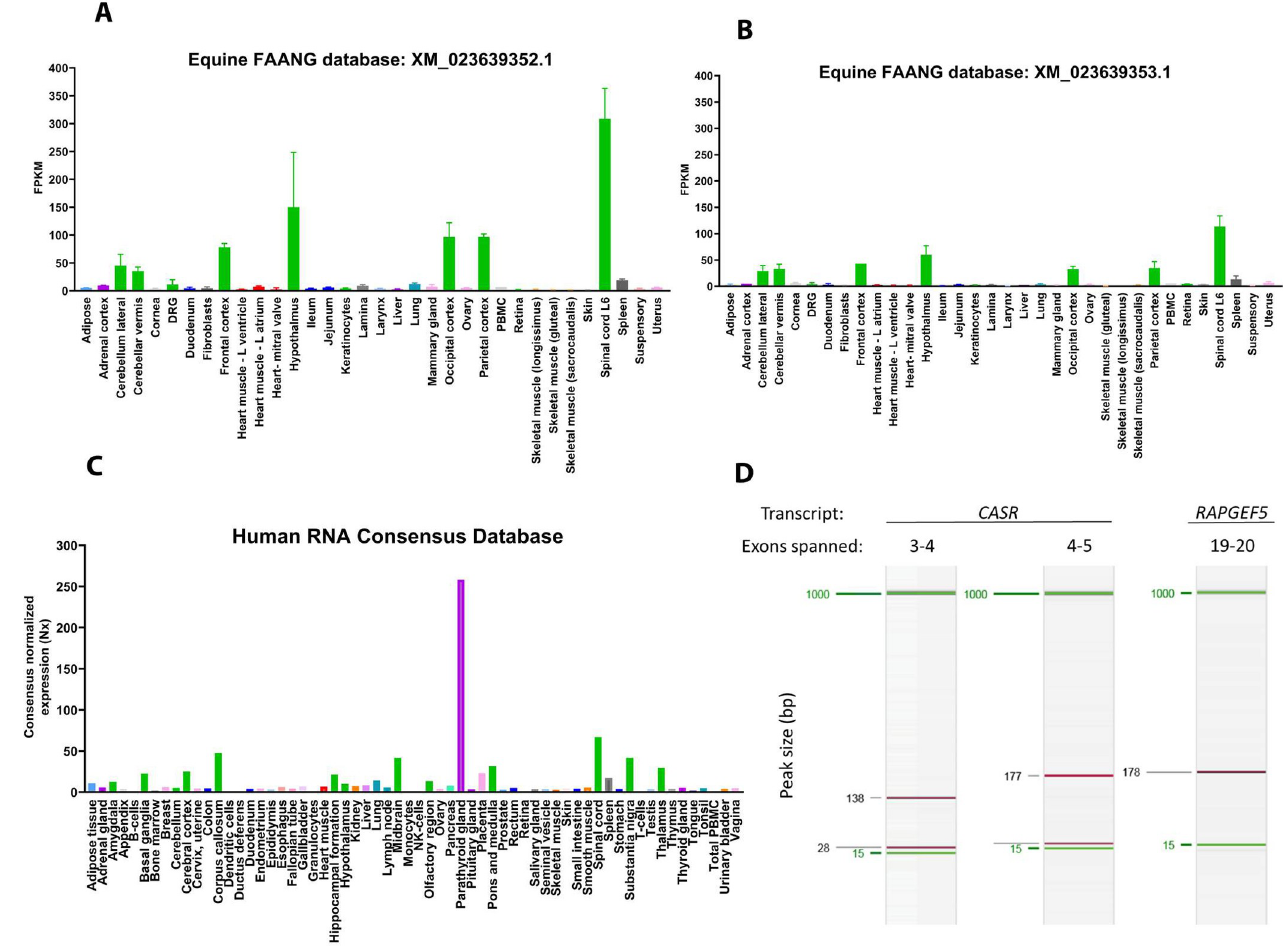
Fig 4. RAPGEF5 transcript expression across tissues in horse (A, B) and human (C). In 45 equine tissues with publicly available RNA-sequencing data from the FAANG initiative, the two NCBI annotated equine transcripts of RAPGEF5 (A) XM_023639352.1 and (B) XM_023639353.1 were most highly expressed in brain and spinal cord (green; median and 95% confidence interval graphed for n = 2 horses). Parathyroid tissue was not included in this biobank. (C) In humans, RAPGEF5 transcript expression was enriched in the nervous system (green) and endocrine tissues (purple). Parathyroid gland had the highest RNA expression of RAPGEF5 . FPKM = fragments per kilobase of transcript per million mapped reads, Nx = consensus normalized expression. (D) RAPGEF5 is expressed in parathyroid tissue from a healthy control foal (primer sets spanning exons 19–20; expected product size 178 bp). Two primer sets, spanning exons 3–4 and 4–5 from CASR , were used as an internal control to confirm parathyroid tissue.